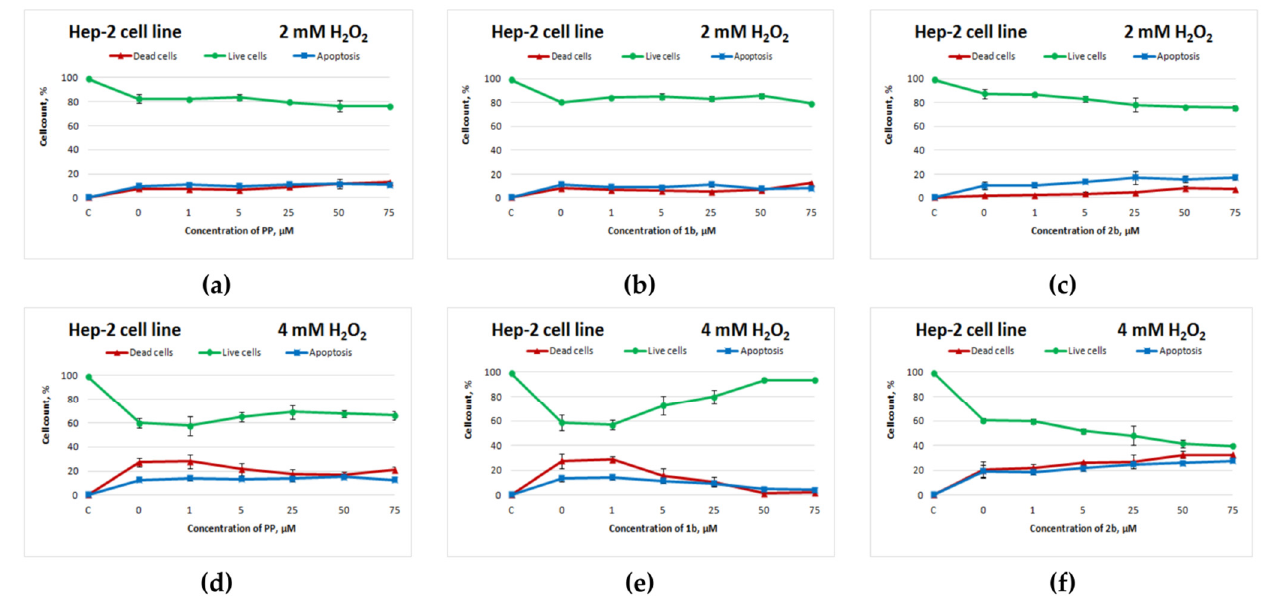
Figure 4. Effects of potassium phenosan [ PP , potassium 3-(3,5-di-tert-butyl-4-hydroxyphenyl)propionate], potassium 3-[3-(3,5-di-tert-butyl-4-hydroxyphenyl)propylseleno]propionate ( 1b ) or potassium 3-[4- hydroxy-3,5-dimethylbenzylthio]propanoate ( 2b ) on the viability of Hep2 cells under the influence of H 2 O 2 as determined by dual staining with Hoechst 33342/propidium iodide. Cells were cultured in the presence of each salt for 24 h, after which they were exposed to H 2 O 2 for 4 h. Point C represents control cells without treatment with hydrogen peroxide. ( a – c )—effect of PP , 1b and 2b on the viability of tumour cells under the influence of 2 mM H 2 O 2 , respectively, ( d – f )—effect of PP , 1b and 2b on the viability of tumour cells under the influence of 4 mM H 2 O 2 ,